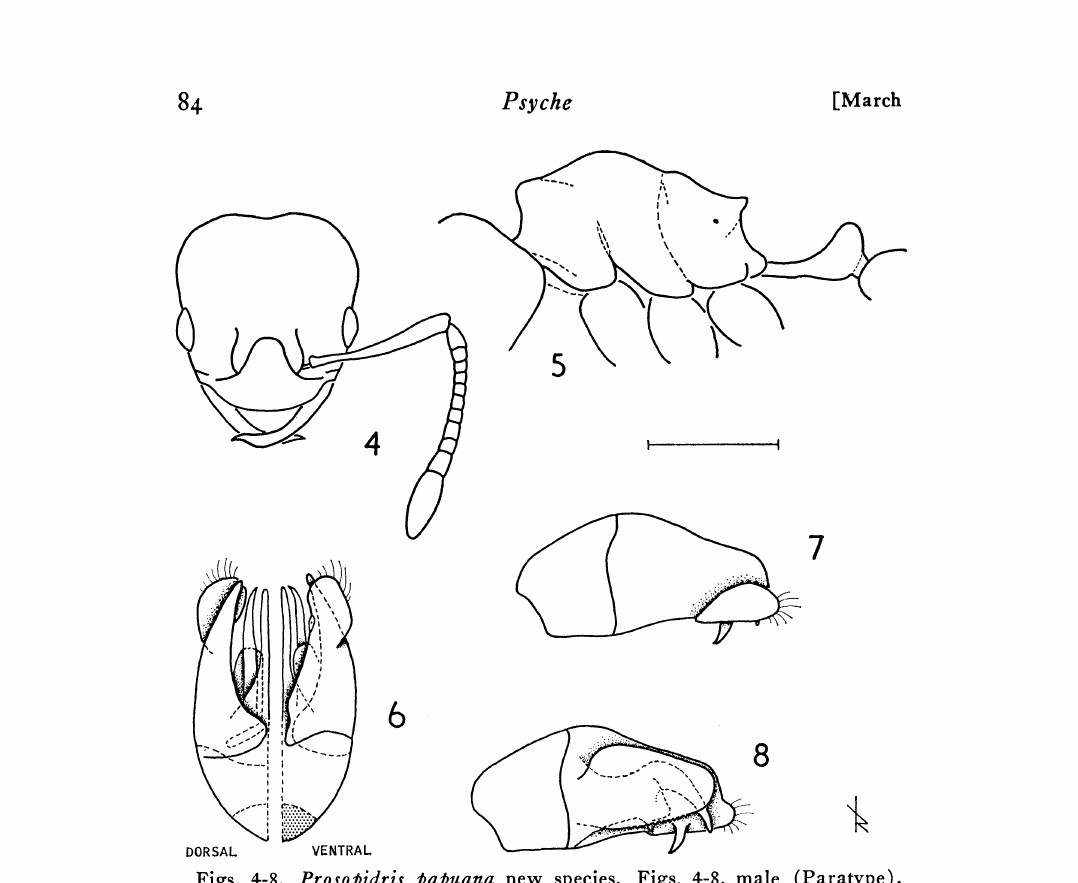
Figs. 4-8. Prosopidris pauana new species. Figs. 4-8, male (Paratype). Fig. 4. Head, frontal view. Fig. 5. Mesosoma and petiole, lateral view. Fig. 6. Genitalia, dorsal and ventral views. Fig. 7. Genitalia, let half, external lateral view, showing gonoforceps and basal ring. Fig. 8. Geni- talia, right half, internal lateral view, showing penis valve, volsella, gonoforceps and basal ring. Scale line: 0.40 mm., for Figs. 4- and 5; 0.15 mm., for Figs. 6, 7 and